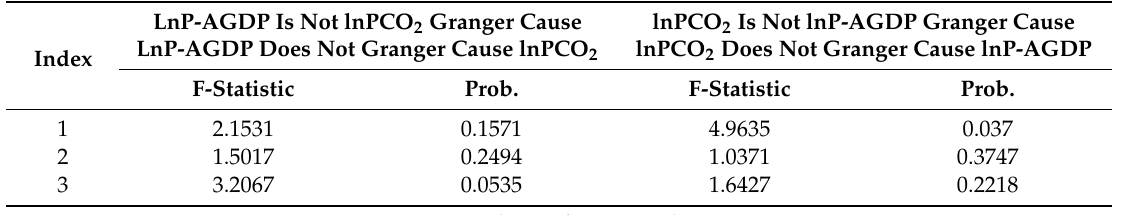
Table 6. Causality test results based on di ff erent Lag